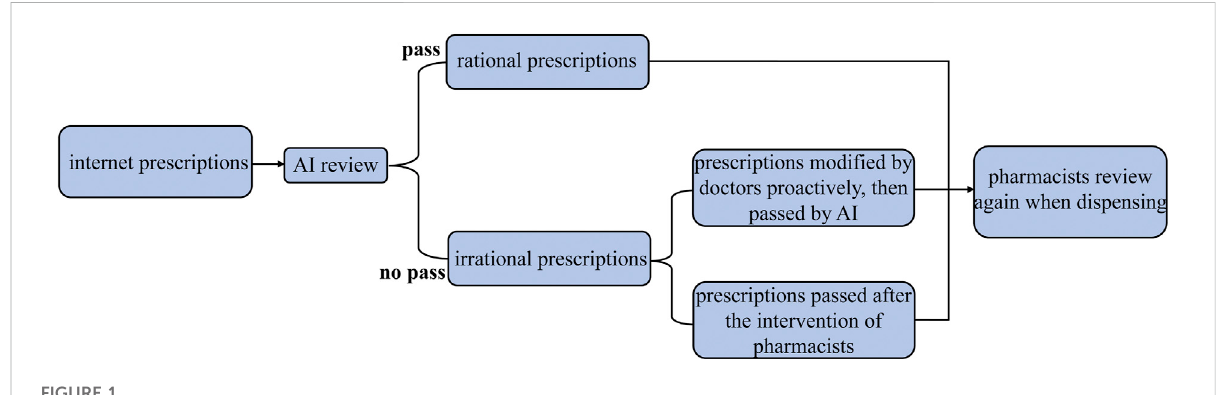
FIGURE 1 Prescriptions preview